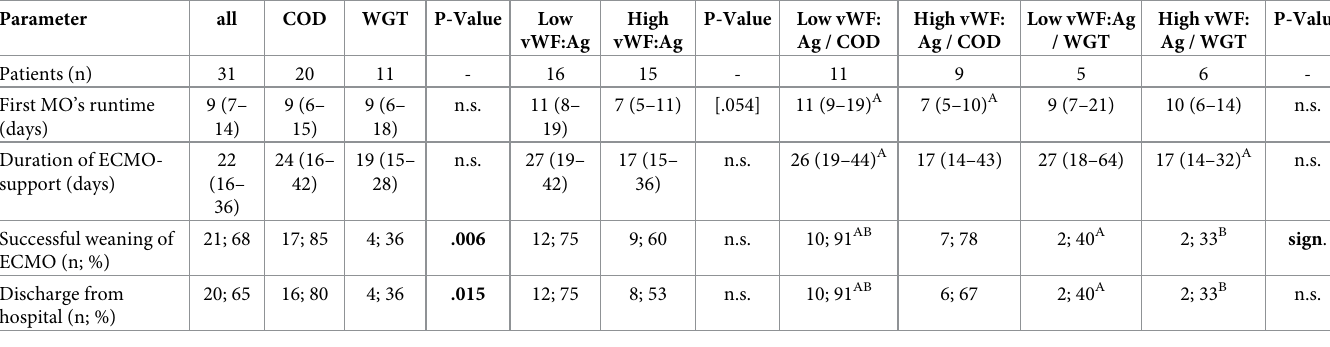
Table 4. MO runtime and